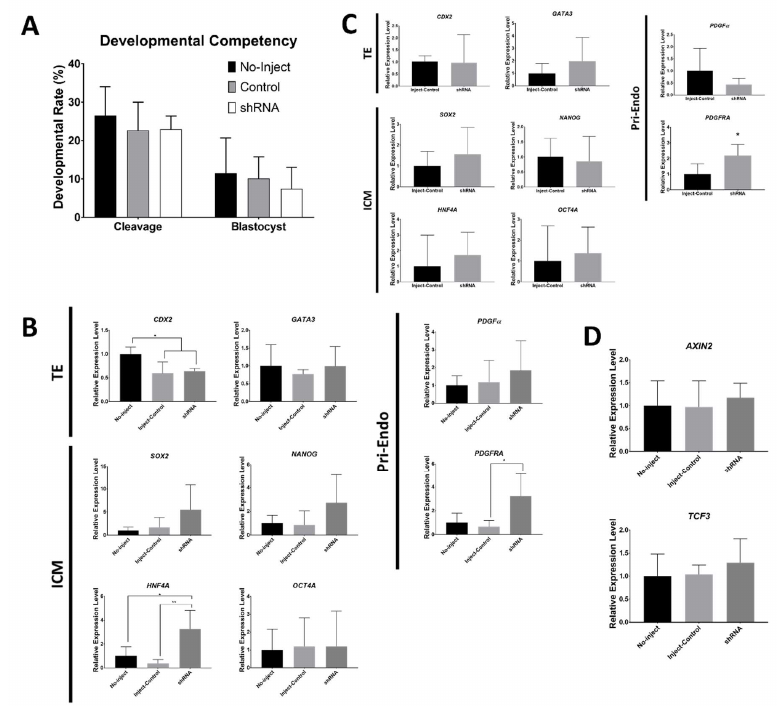
Figure 3. Analysis of embryos after microinjection of anti-Dab2 shRNA vector. No-inject; embryos without microinjection, Control; embryos that were injected with an empty vector without shRNA, shRNA; shRNA vector-injected embryos (1:1 mixture of candidate 1 and 2). ( A ) Development competency of embryos with or without microinjection. ( B ) Expression levels of marker mRNAs in day 7 embryos (Trophectoderm (TE); GATA3 , CDX2 ; Inner cell mass (ICM); SOX2 , NANOG , HNF4A ; Primitive endoderm (Pri-Endo); PDGFα , PDGFRA ). ( C ) Expression levels of marker mRNAs in day 5 embryos (Trophectoderm; GATA3 , CDX2 ; Inner cell mass; SOX2 , NANOG , HNF4A , OCT4A ; Primitive endoderm; PDGFα , PDGFRA ). ( D ) Expression levels of DAB2 target candidates ( AXIN2 and TCF3 )